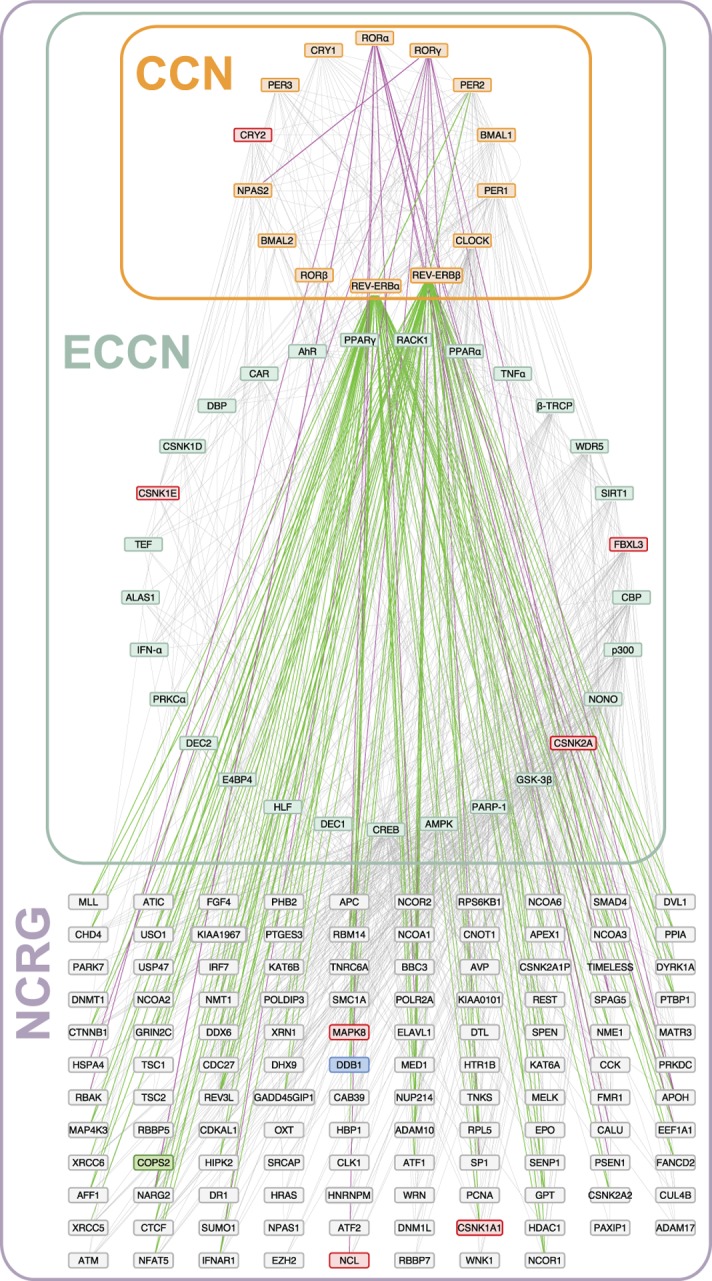
Transcriptional regulation of the CCN/ECCN extension network of 118 genes by REV-ERB and ROR.Regulatory interactions of REV-ERB α/β with NCRG genes (green lines) were derived from the locations of physical binding of these proteins in two ChIP-seq experiments [16, 17]. The ROR α/ γ interactions (purple lines) were adopted from the report of a third ChIP-seq experiment [22]. Genes with an observed phenotype in the genome-wide RNAi screen [28, 29] are shown with a coloured box, red indicating long period, blue a high amplitude, and green a short period.